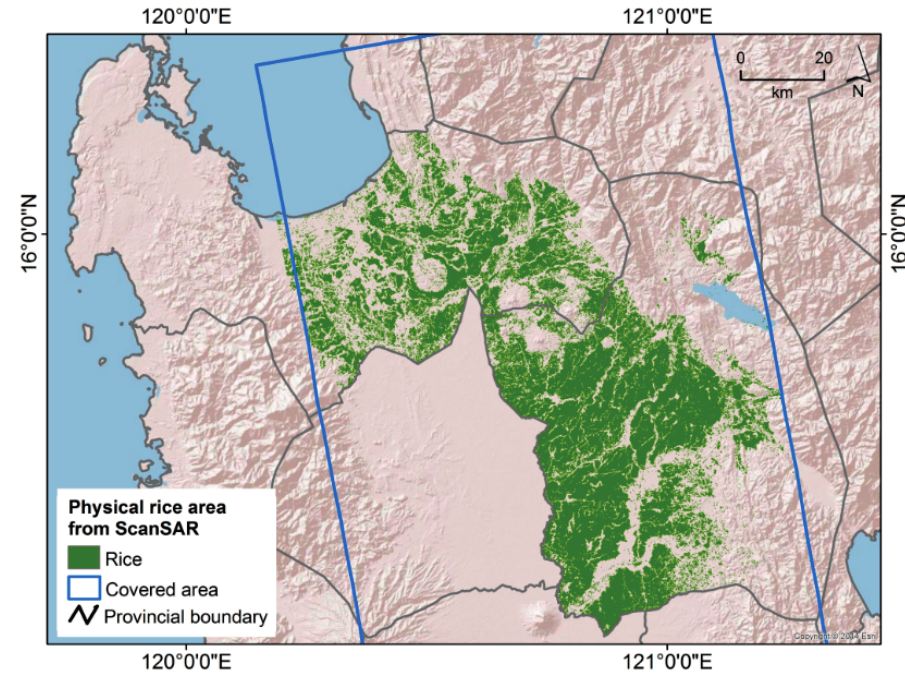
Figure 6. Physical rice cropped area map for 2012 – 2013 derived from TSX ScanSAR (WS) and CSK ScanSAR (DS)